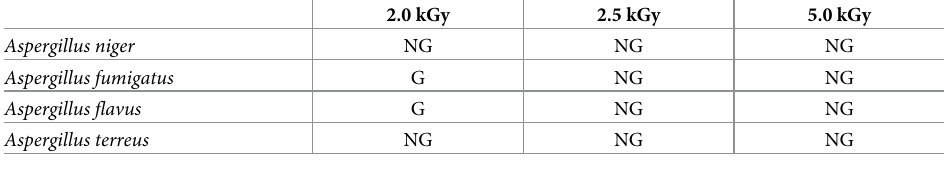
Table 2. PCR detection and viability of various Aspergillus spp. after X-ray